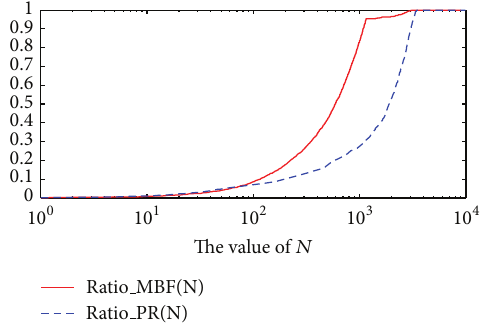
Figure 11: The similarity of the results of the two algorithms.